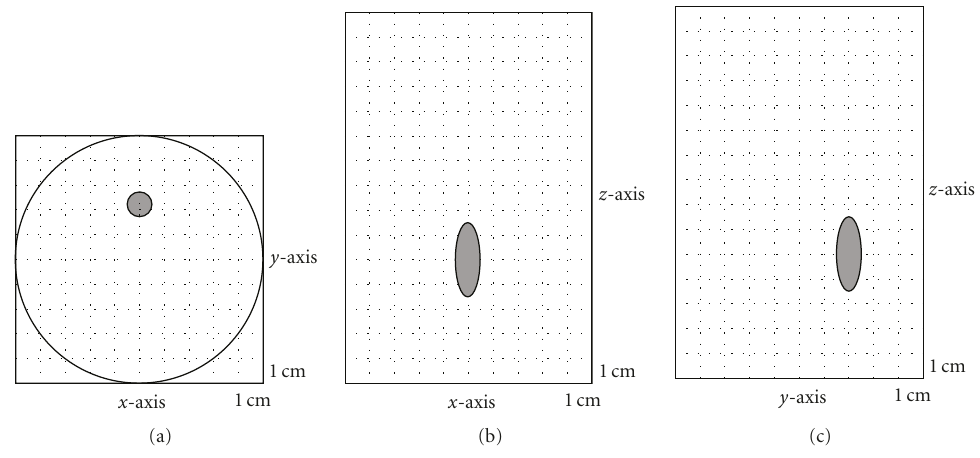
Figure 6: Physical setup for experiment 1. (a) ( x , y ) plane view, (b) ( x , z ) plane view, and (c) ( y , z ) plane view.